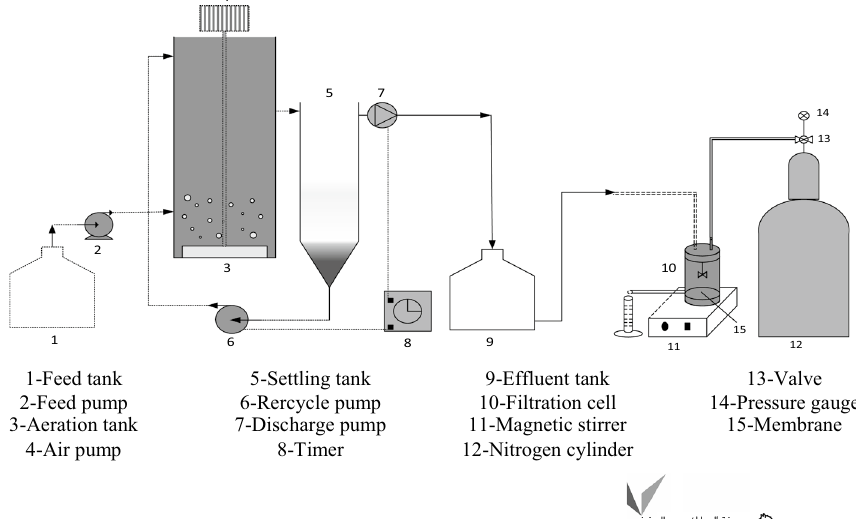
Fig. 1 Schematic structure of AS-MP used in this